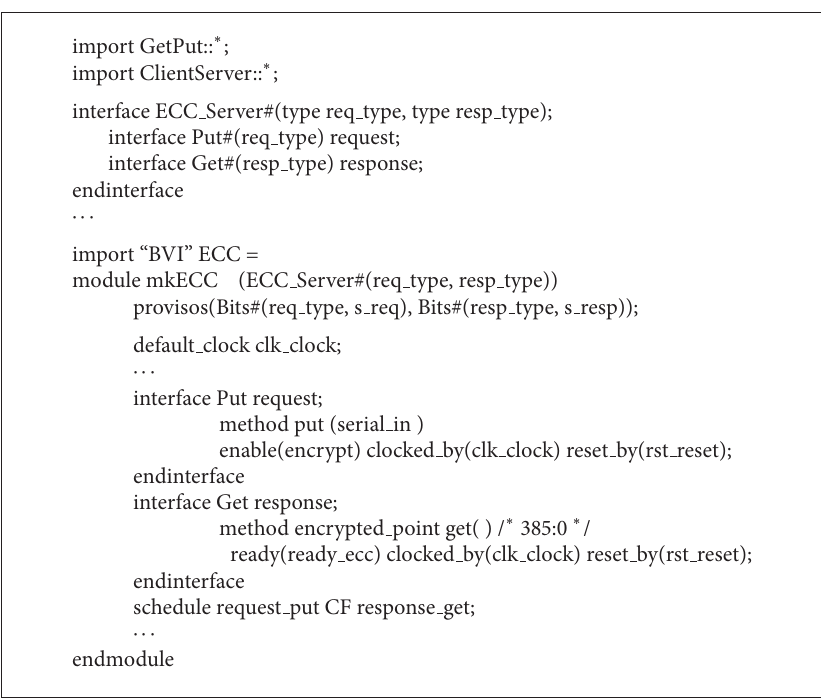
Algorithm 3: BSV wrapper including the interfaces, modules, and